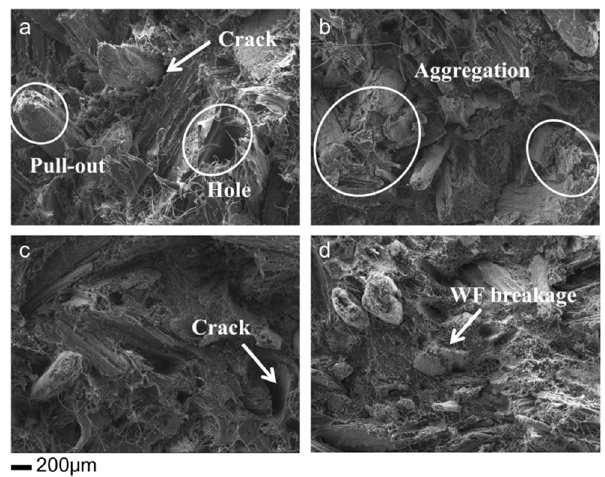
Figure 10. Impact fracture surface of untreated and emulsion treated WF/HDPE composites. ( a ) and ( b ) control: without treatment; ( c ) paraffin emulsion treatment; ( d ) Pickering emulsion treatment.